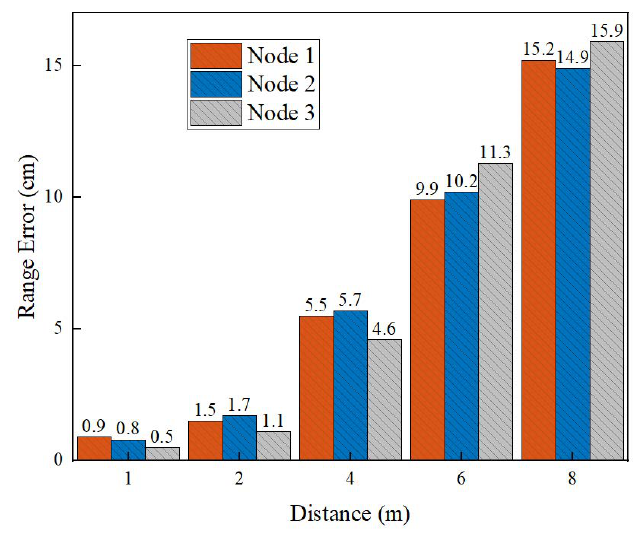
Figure 17. Impact of the distance on ranging accuracy.